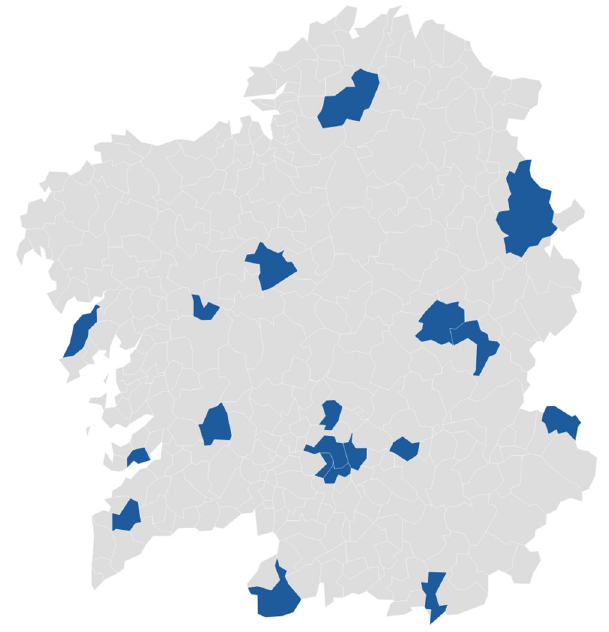
Figure 1. Distribution of geographical origin by municipality in blue of the bee pollen samples in Galicia (Northwest Spain). Created with Datawrapper.